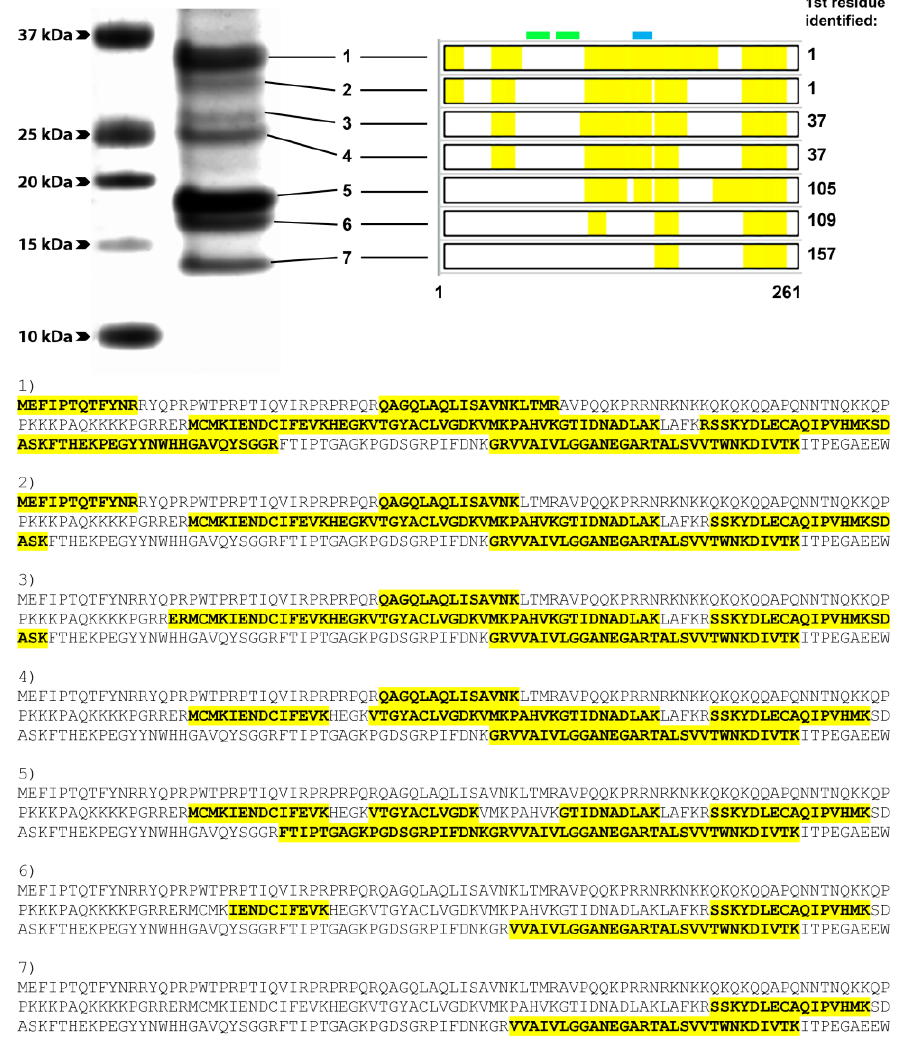
Figure 7. Coverage of the CHIKV capsid protein by peptides identified via mass spectrometry analysis of different bands excised from SDS-PAGE of boiled and reduced proteins immunoprecipitated by a group 1 mAb, 1.7B2. Indicated in green and blue are the predicted positions of the CHIKV CP NLS and NES, respectively. Sequences for peptides identified within each respective CHIKV CP band (1–7) are bolded and highlighted in